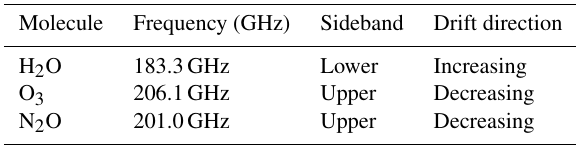
Table 1. The key spectral lines in the MLS 190GHz band ( f LO = 191 .